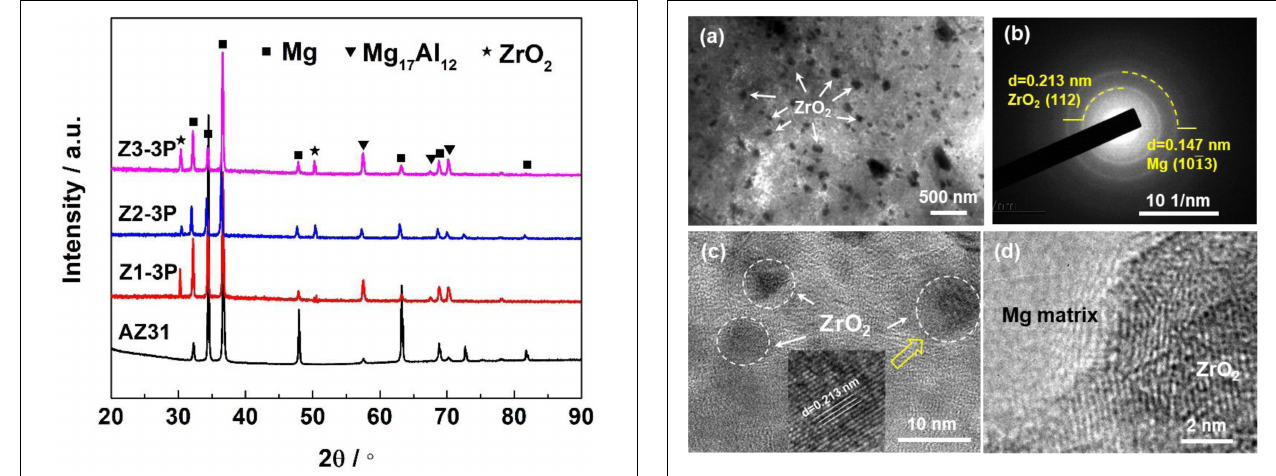
FIGURE 6 | XRD patterns of AZ31 alloy and FSPed AZ31/ZrO 2 composites.